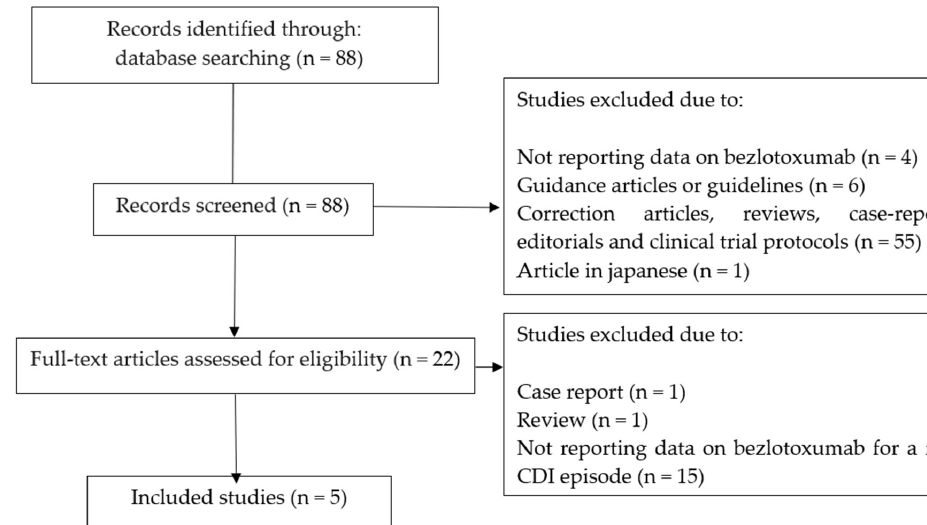
Figure 1. Flowchart depicting the selection process of studies included in this study. Table 1. Summary description of the 5 studies providing data on the use of bezlotoxumab for the prevention of rCDI after a first CDI episode.